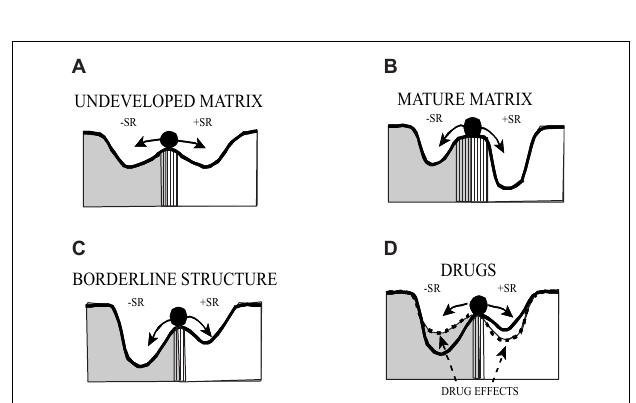
FIGURE 6 | (A) Undifferentiated matrix, (B) early bipolar matrix, (C) transitional matrix, and (D) differentiated adult matrix. Visualization of the core concept of object relations theory as a matrix: the configuration of the self in context of objects, with positively and negatively experienced properties (Kernberg, 1976). Remarks: The term “object representation” is translated here for reasons of general applicability into “environmental image” and also “self-representation” is translated to “self-image”.